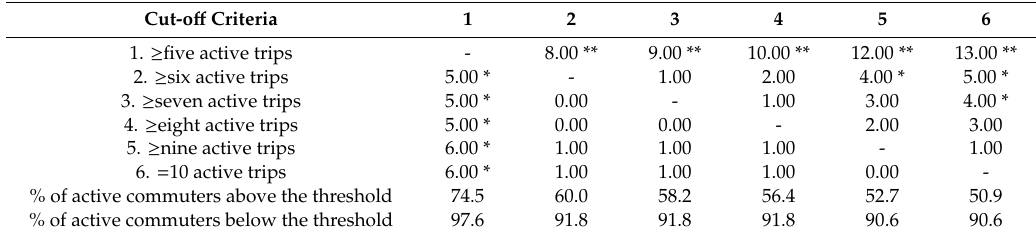
Table 3. Cochran’s Q test values for the percentage of active commuters depending on the number of weekly active trips to and from school for participants below and above the threshold